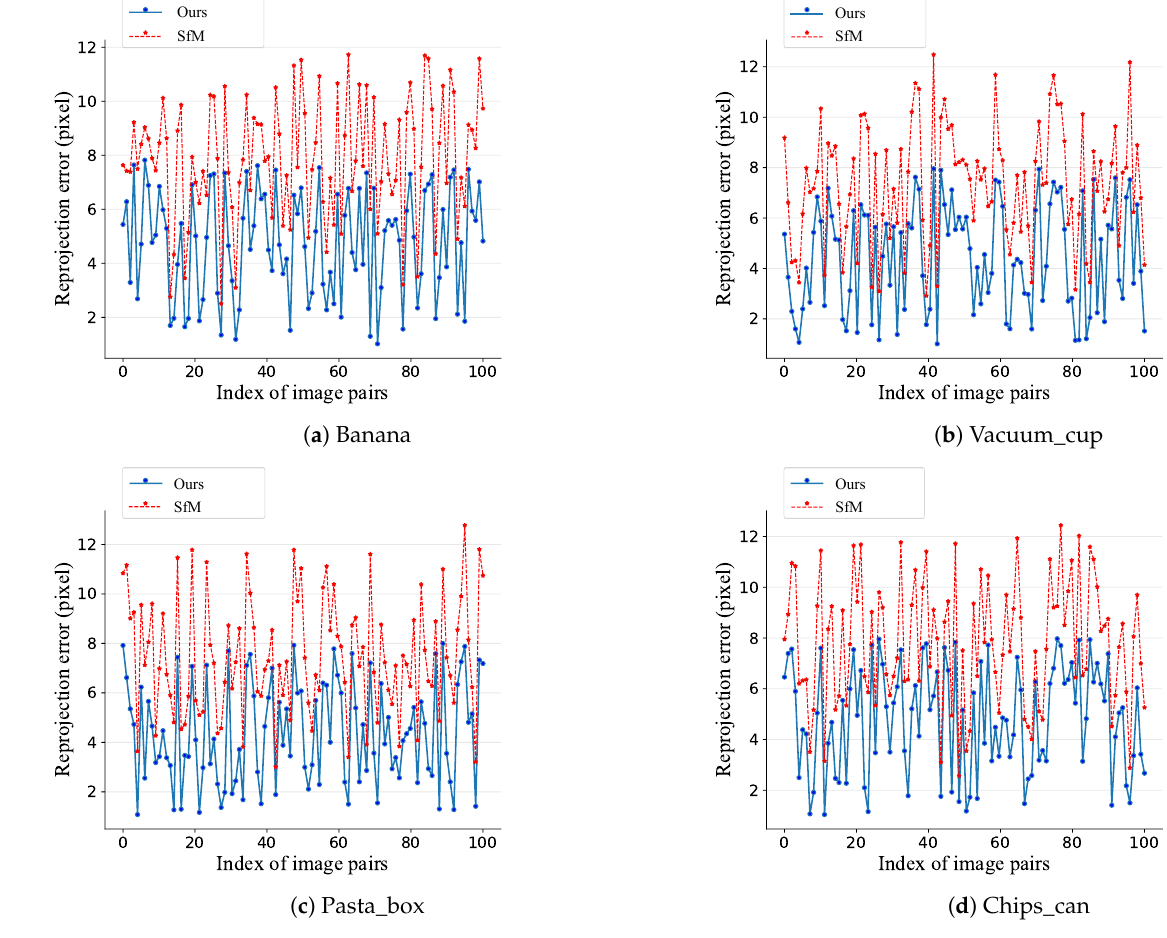
Figure 9. Reprojection error comparison with and without pose refinement for different objects.